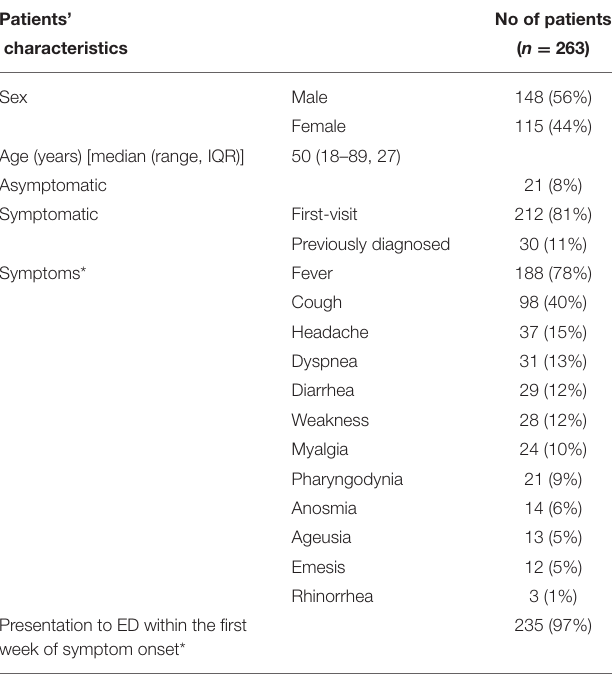
TABLE 1 | Demographic data of the study population. Patients’